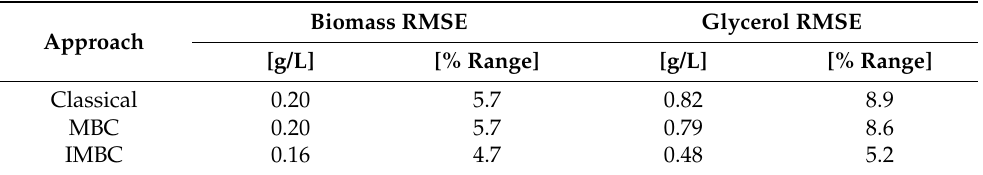
Table 4. Cross-validation of predicted glycerol and biomass concentrations with offline measurements. The prediction was performed by the chemometric model (PCR) trained with simulated glycerol and biomass concentrations. In the case of IMBC, the glycerol concentration was indirectly predicted from the process model by using the predicted biomass.